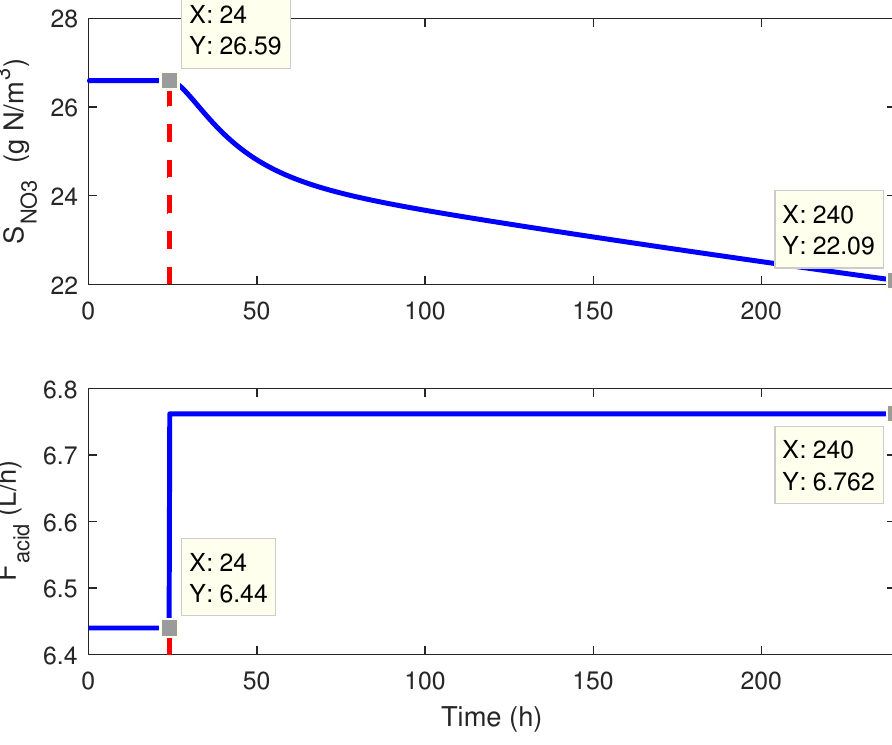
Figure 4. S NO 3 evolution following a step increase in acid